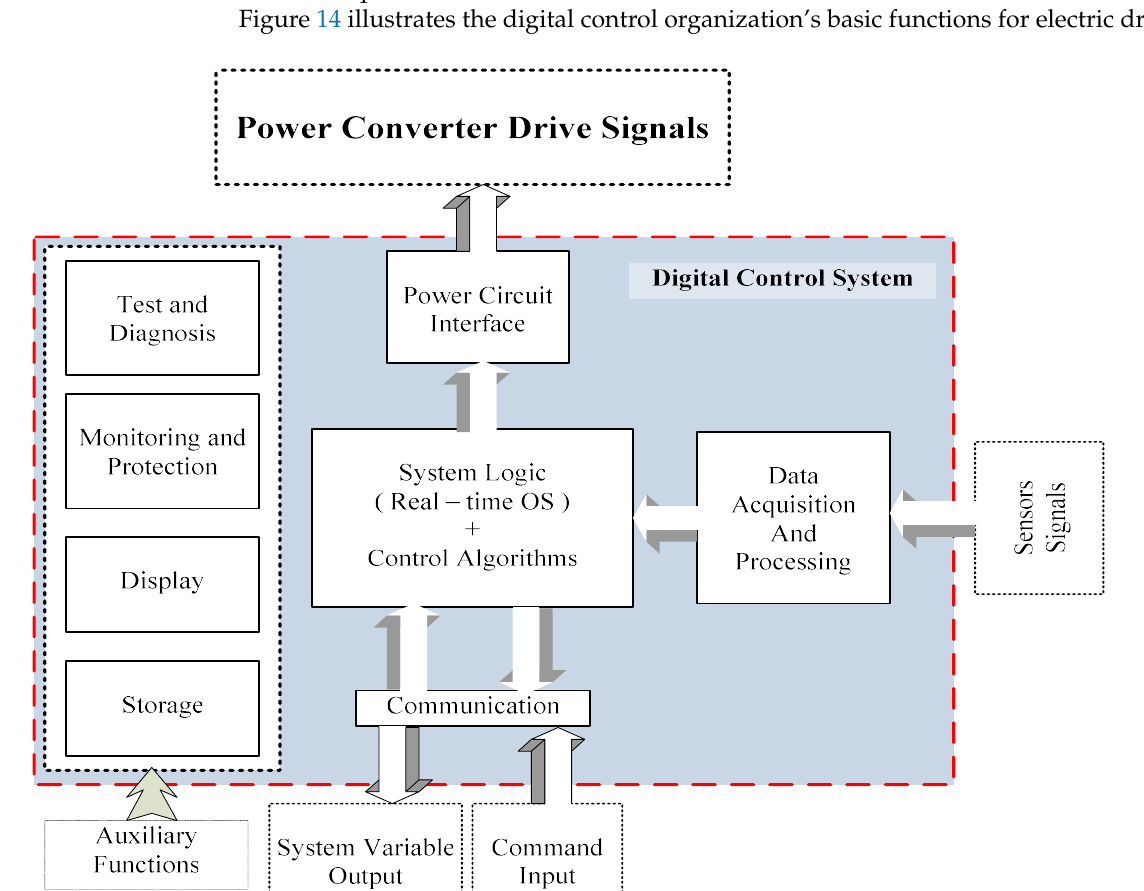
Figure 14. Block diagram of digital control techniques.